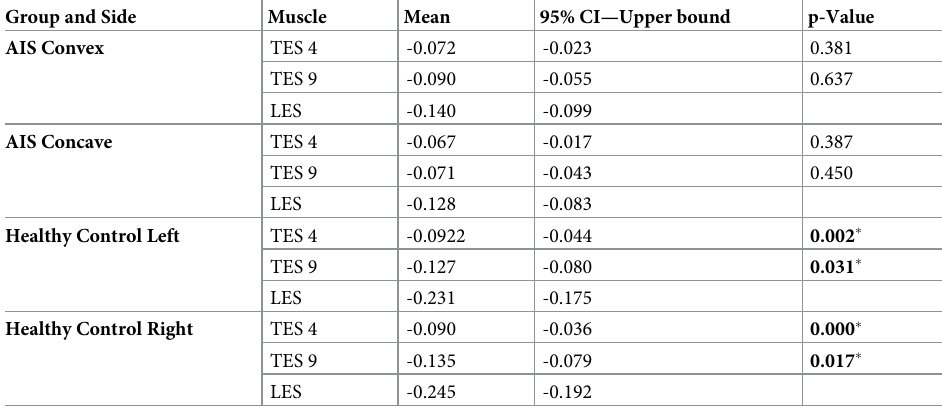
Table 3. Medium frequency slope values of TES4, TES9 and LES during the fatigue task. Group and